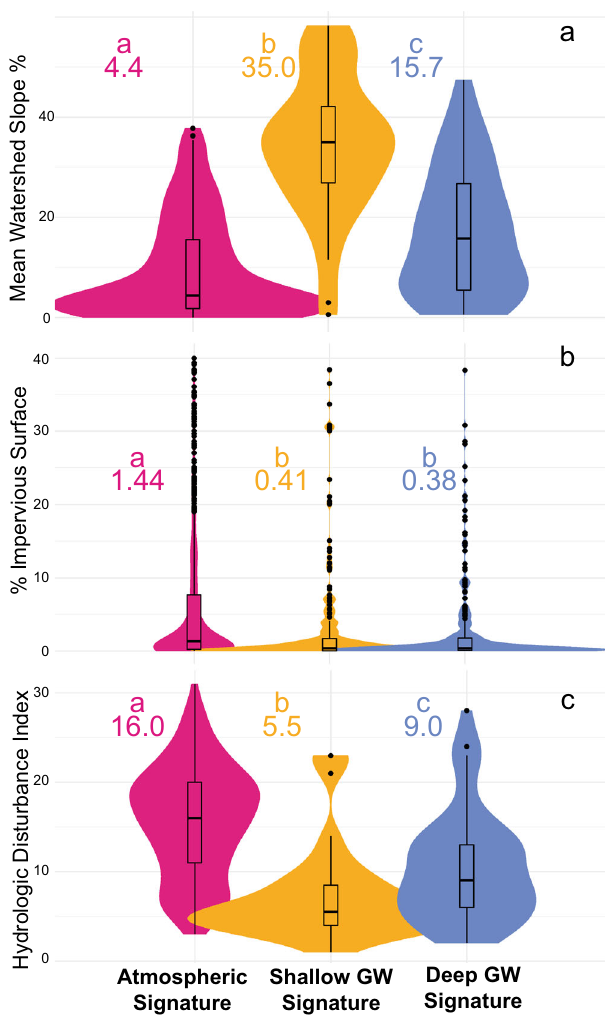
Fig. 3 Watershed properties for groundwater (GW) signature